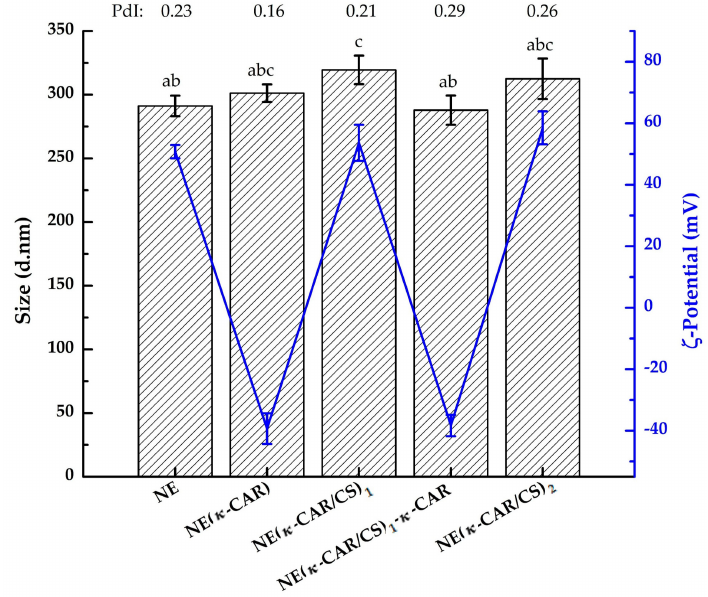
Figure 2. Average hydrodynamic diameter (column), polydispersity index (PdI), and ζ -potential values (line) of NE( κ -CAR/CS) x oil-core nanocapsules, determined by DLS as function of the number of deposited polyelectrolyte layers. Standard deviation is indicated ( n = 3). Different letters (a, b, c) indicate significant differences in average hydrodynamic diameter ( p <